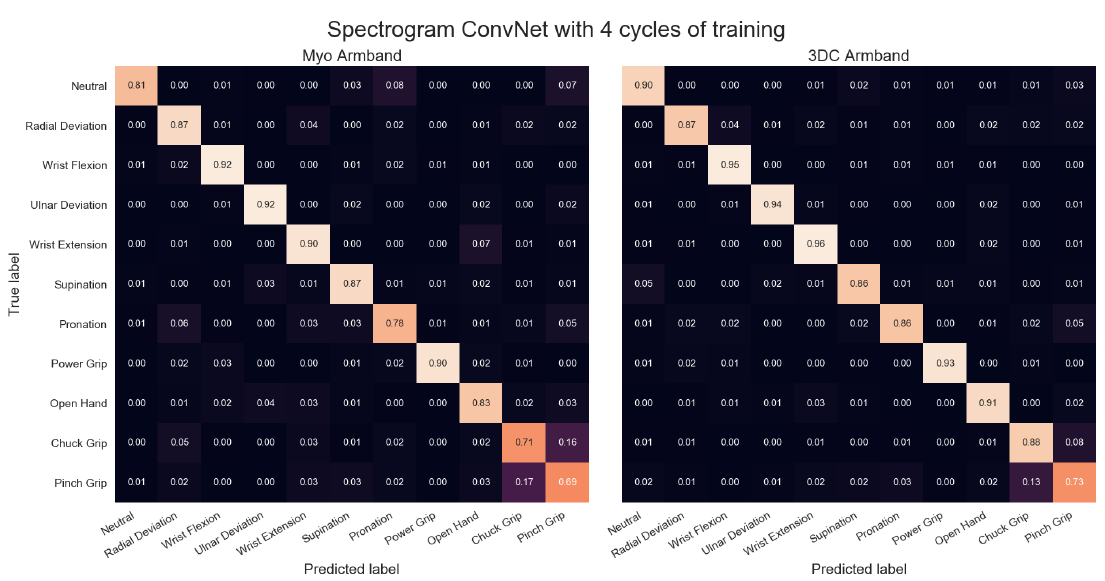
Figure 16. Confusion Matrices for the Myo and the 3DC Armband employing the Spectrogram ConvNet for classification and four cycles of training. A lighter color is